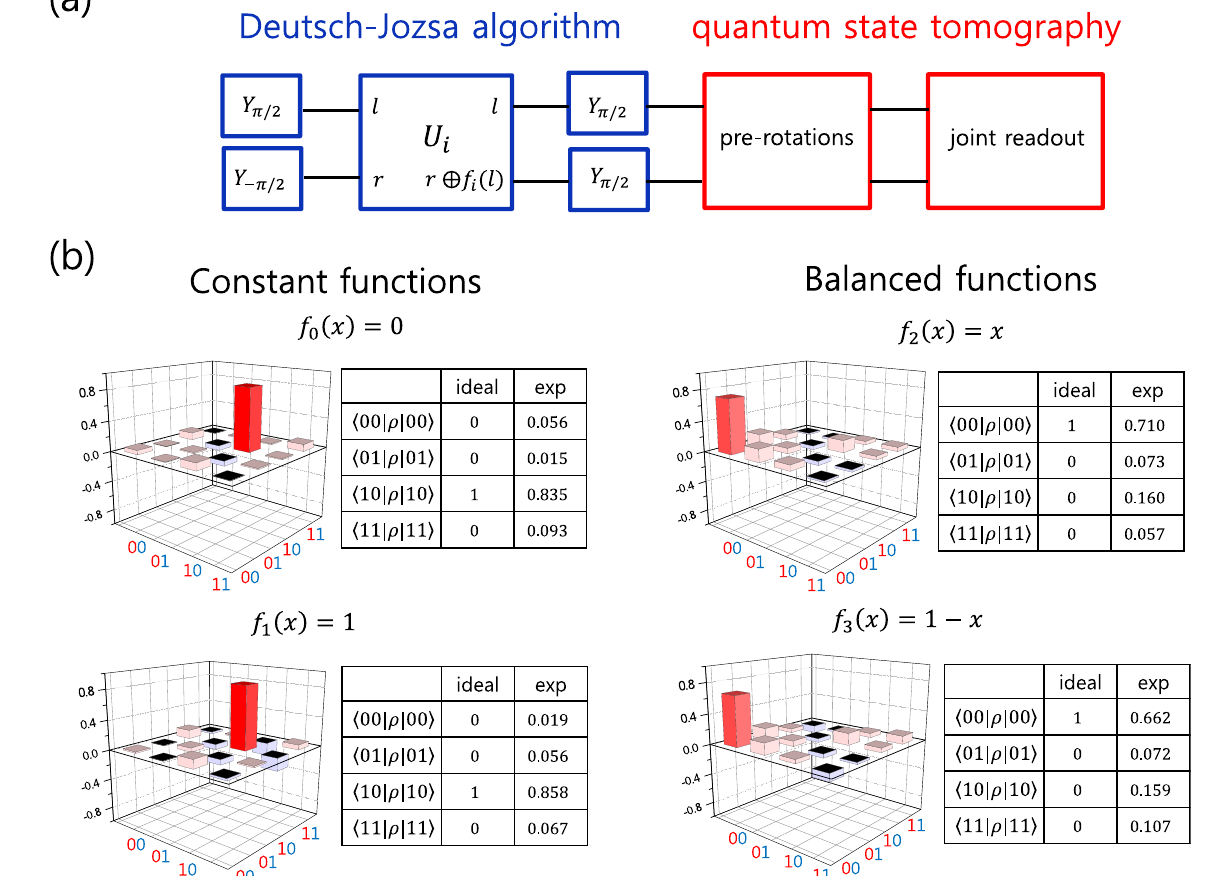
Figure 5. ( a ) Gate sequence for the demonstration of the Deutsch-Jozsa algorithm. ( b ) The real part of the density matrix of the output state for four encoding